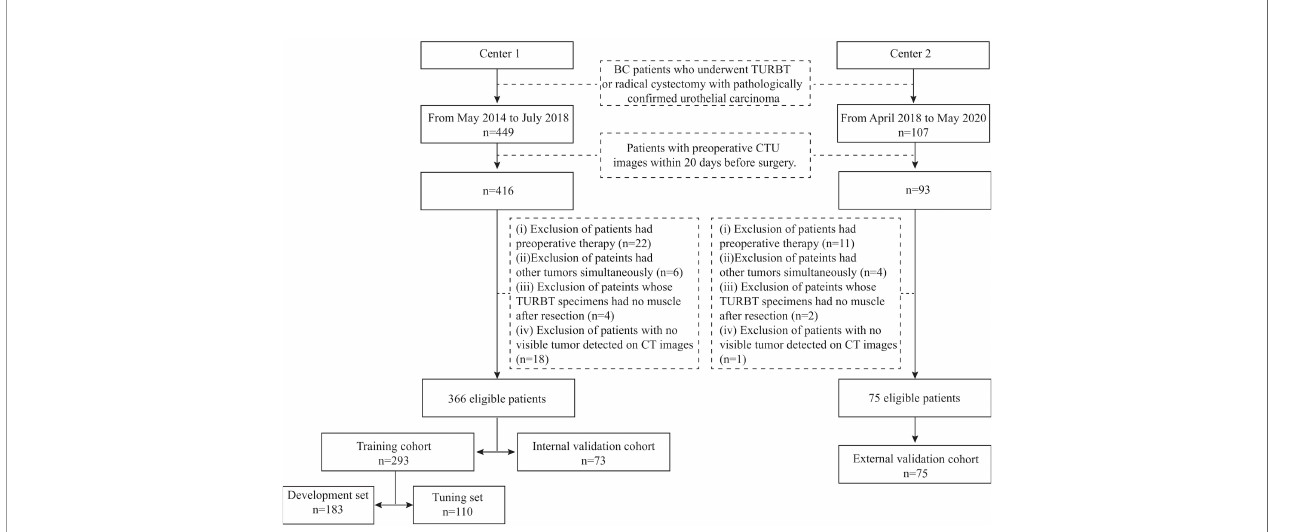
FIGURE 1 | The study fl ow and the recruitment pathway. BC, bladder cancer; TURBT, transurethral resection of bladder tumor; CTU, computed tomography